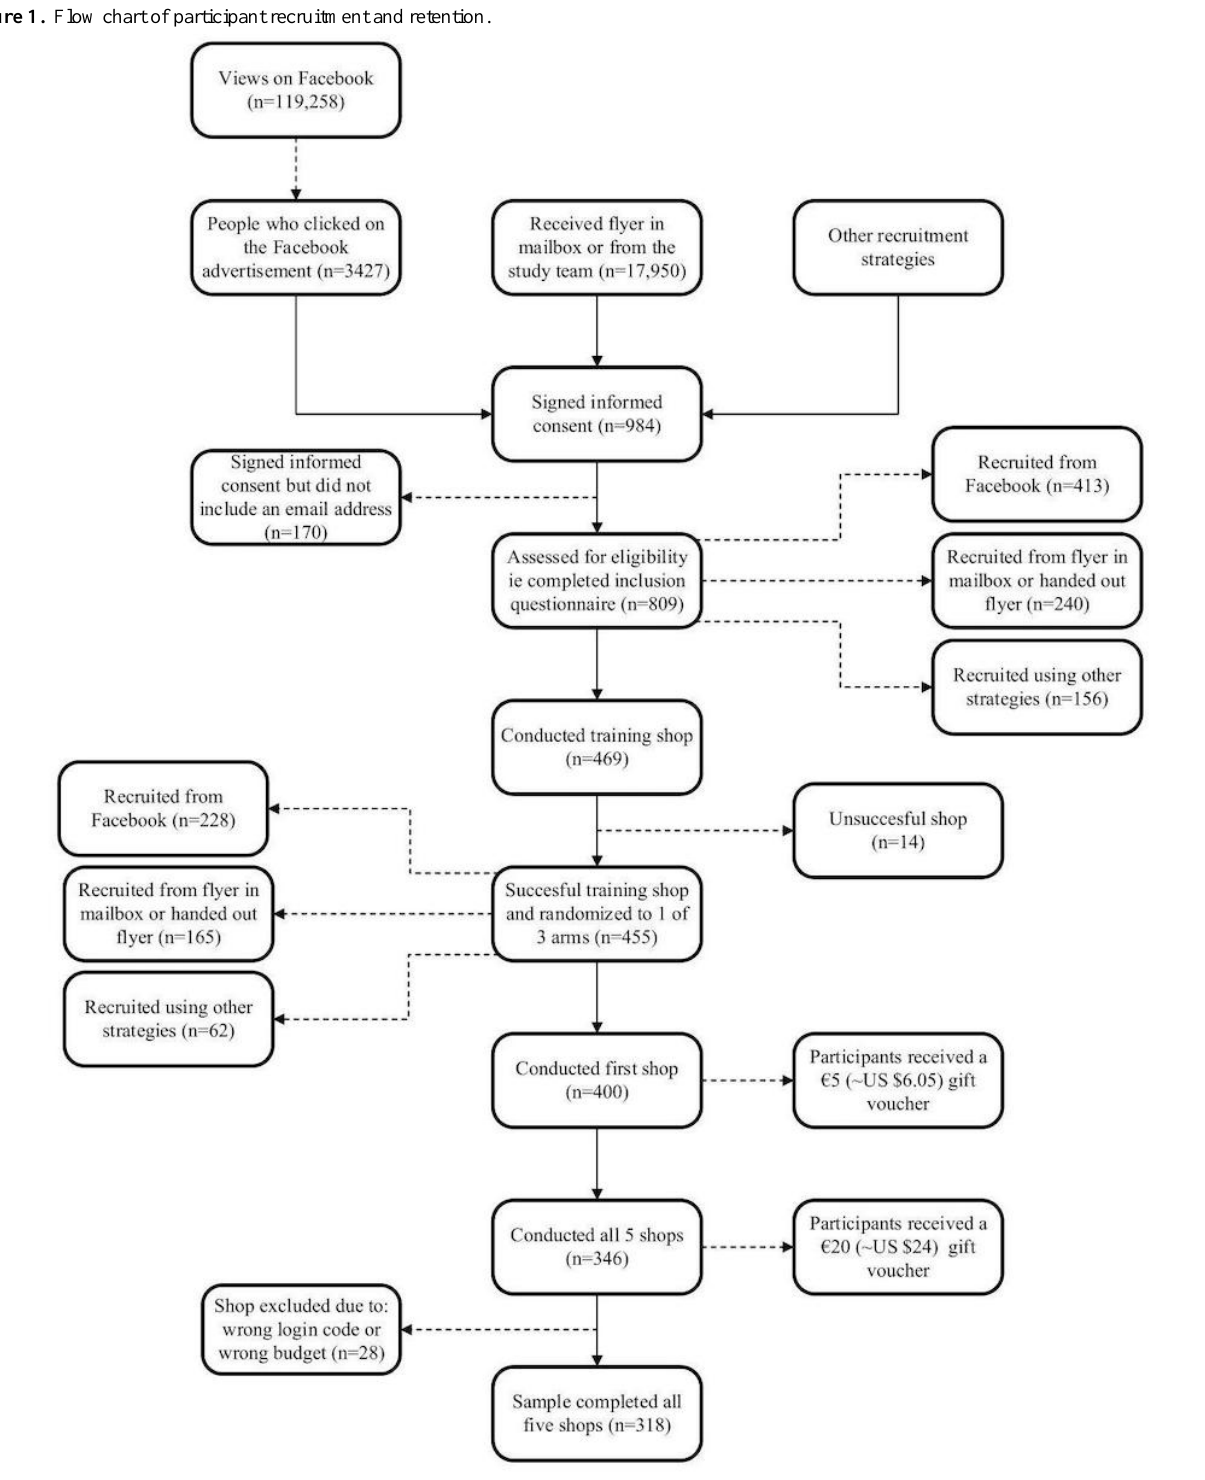
Figure 1. Flow chart of participant recruitment and